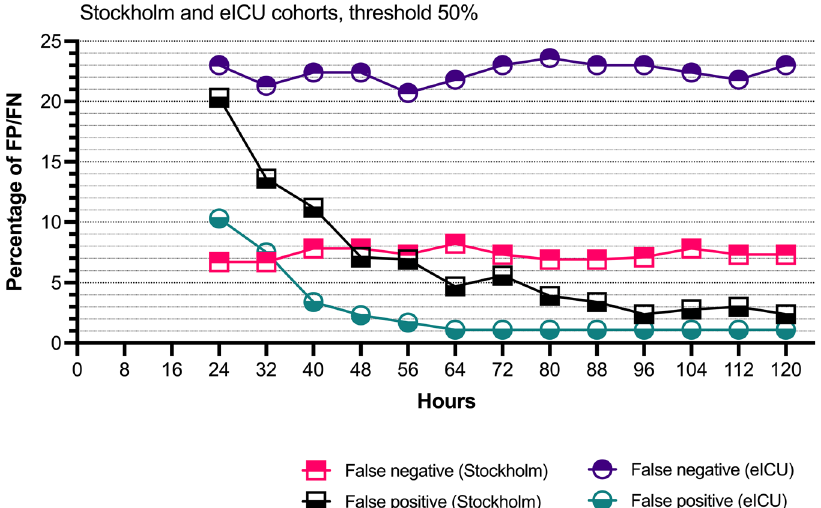
Fig. 5 The false positive and false negative rates. The rates of false positives and false negatives as a function of time in the Stockholm cohort and in the eICU cohort, using a prediction threshold of 50%. The false positive rate drops notably with time indicating improved algorithm reliance as treatment gets prolonged and human clinical decision-making more